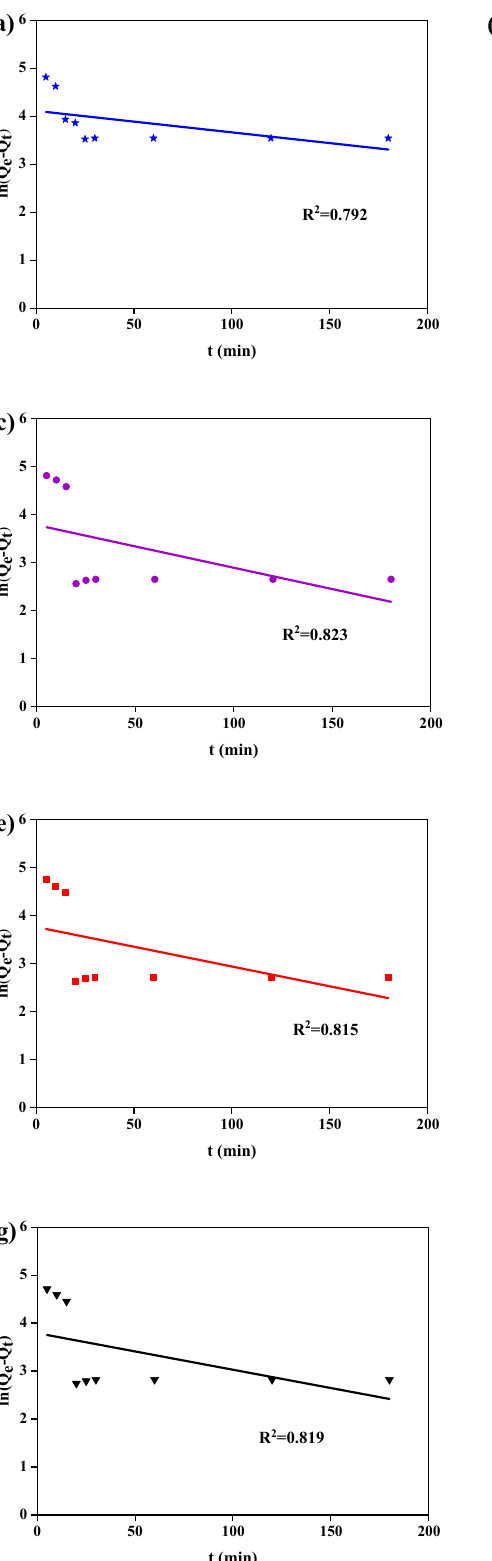
Fig. 8 a and b PAA/PAM/[DMAEMA]MA hydrogel adsorbed MB was fitted by pseudo first and quasi two order kinetic models. c and d RHB was fitted by pseudo first and quasi two order kinetic models.